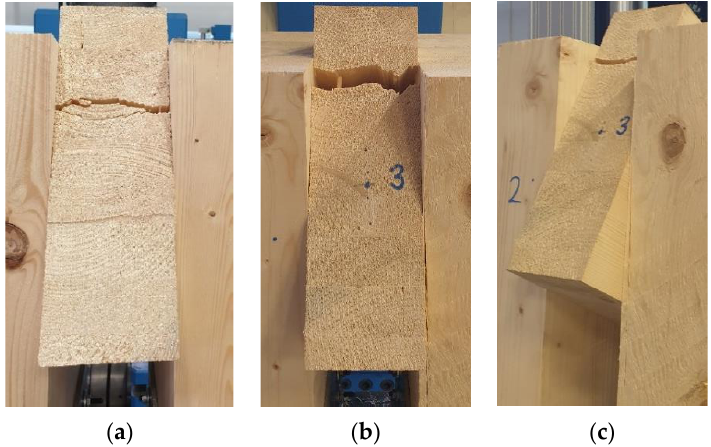
Figure 12. Experiment A, bolts and dowels: ( a ) test 1; ( b ) test 2; ( c ) test 3.